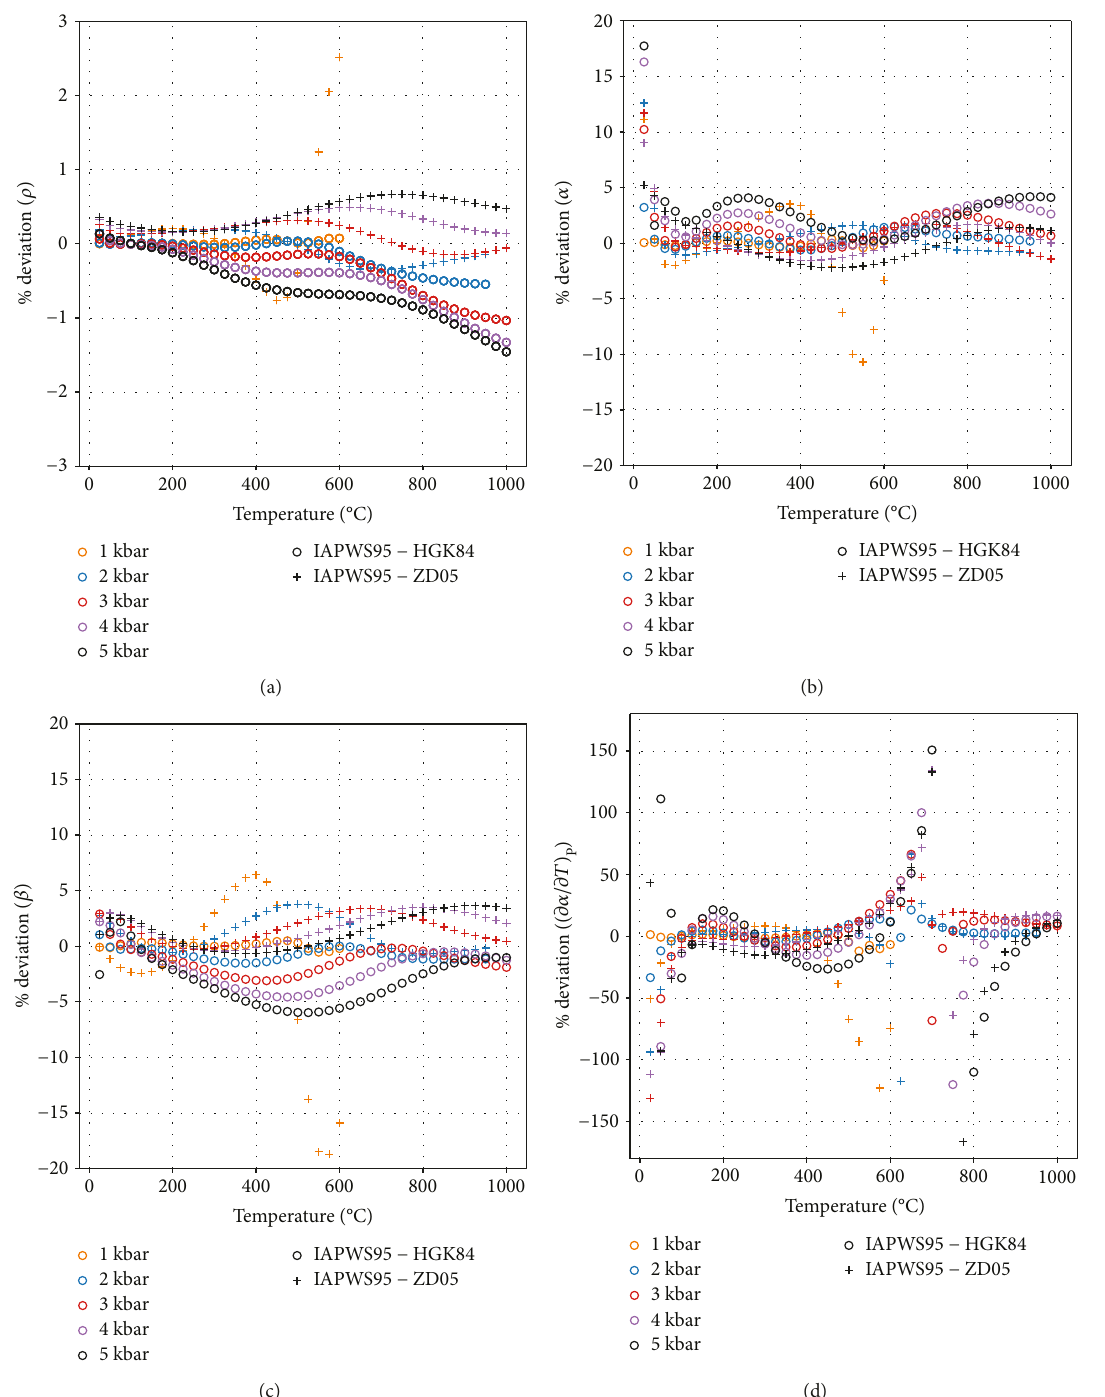
Figure 1: Plots showing the deviation in % of the volumetric properties of water calculated using the HGK84 and ZD05 formulations from those obtained using the IAPWS95 model (25 – 1000 ° C, 1 – 5kbar): (a) ρ (isothermal compressibility), and (d) ∂ α / ∂ T